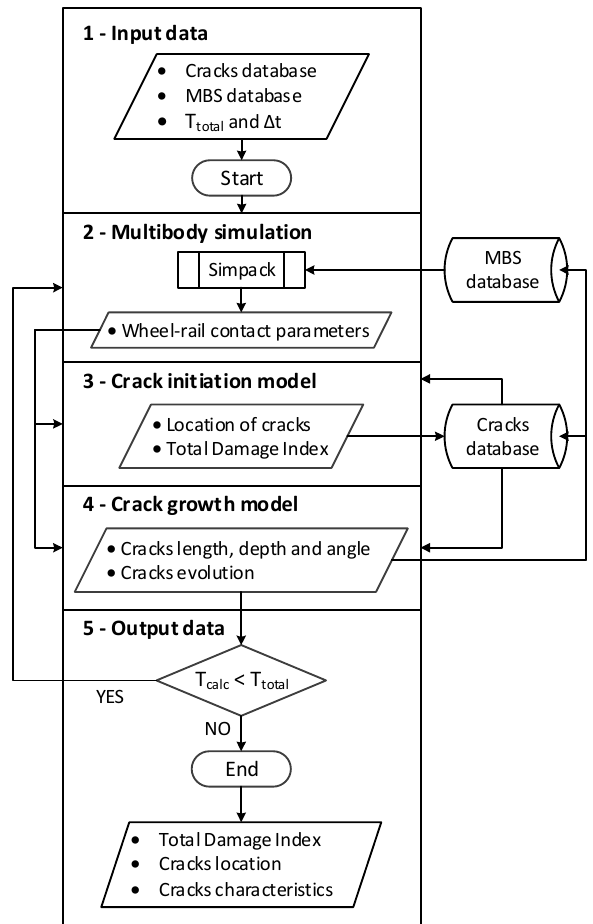
Figure 1. Flowchart of the proposed methodology.